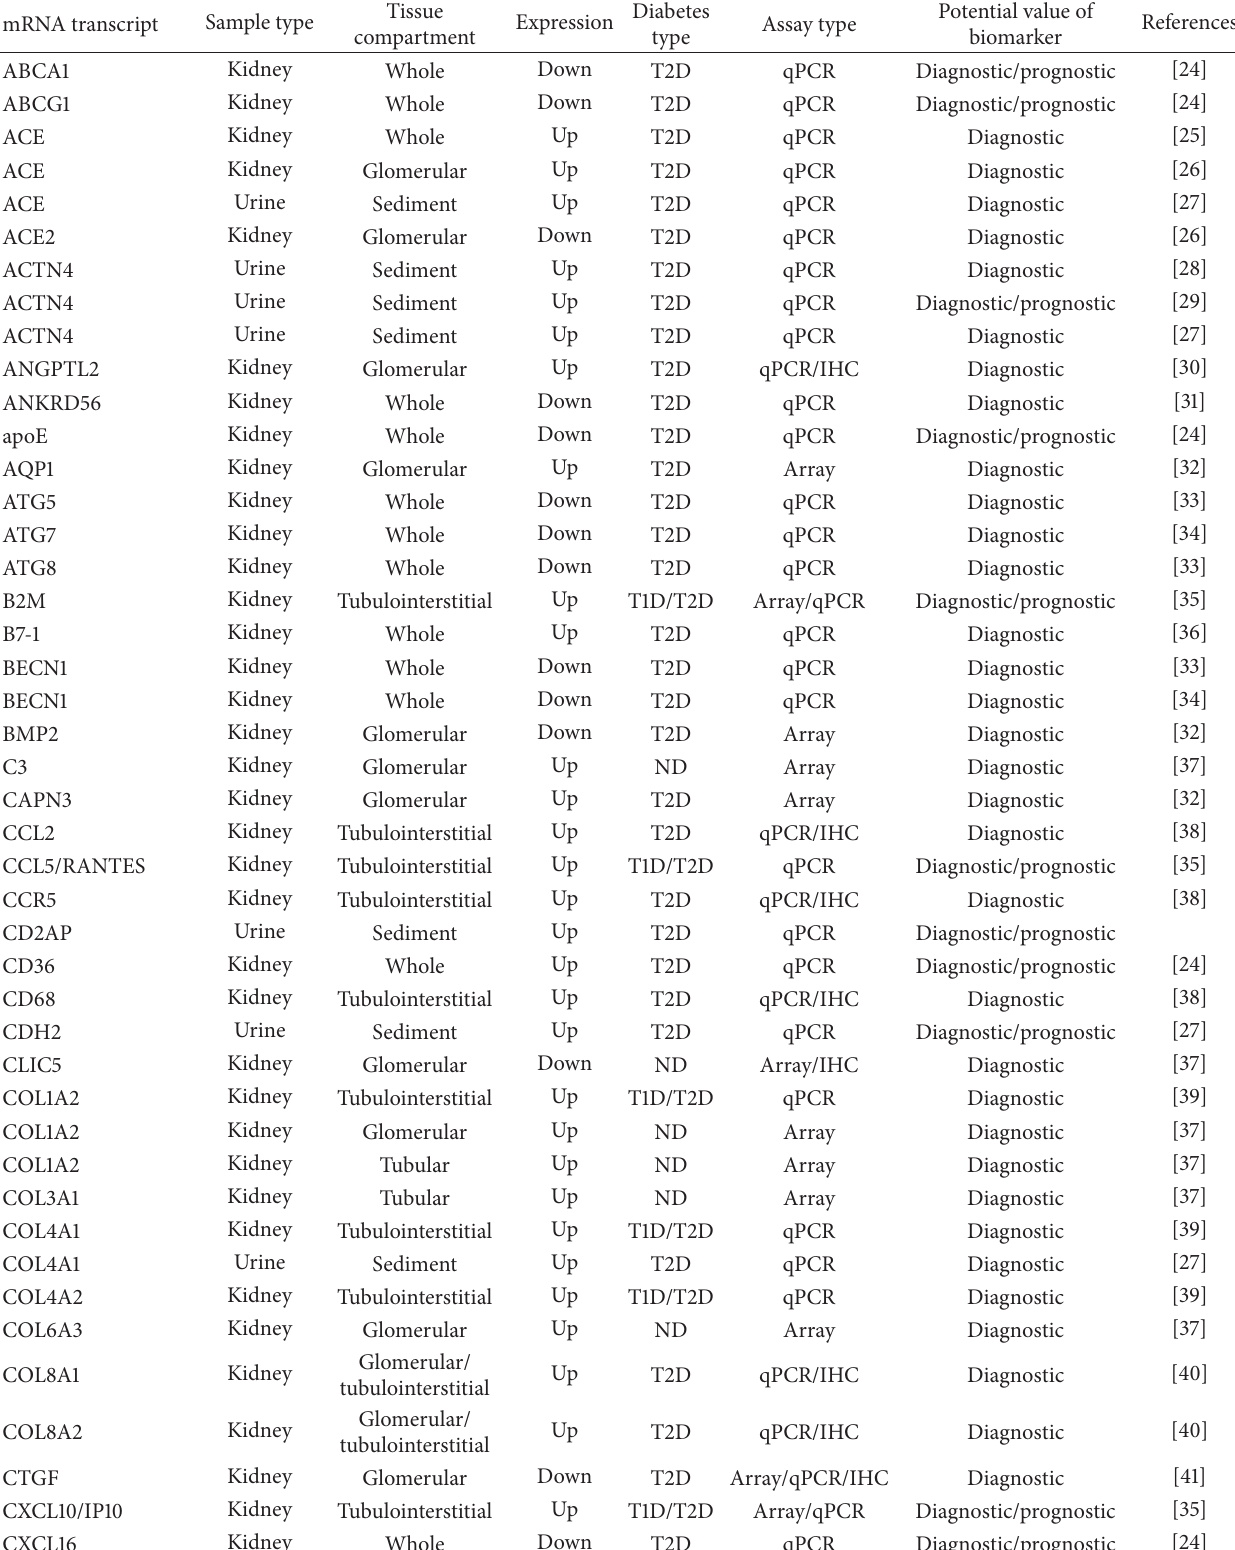
Table 2: Gene expression markers. Collection of coding RNA transcripts showing deregulation in DN. List is ordered alphabetically. IHC: immunohistochemistry. SAGE: serial analysis of gene expression; NGS: next-generation